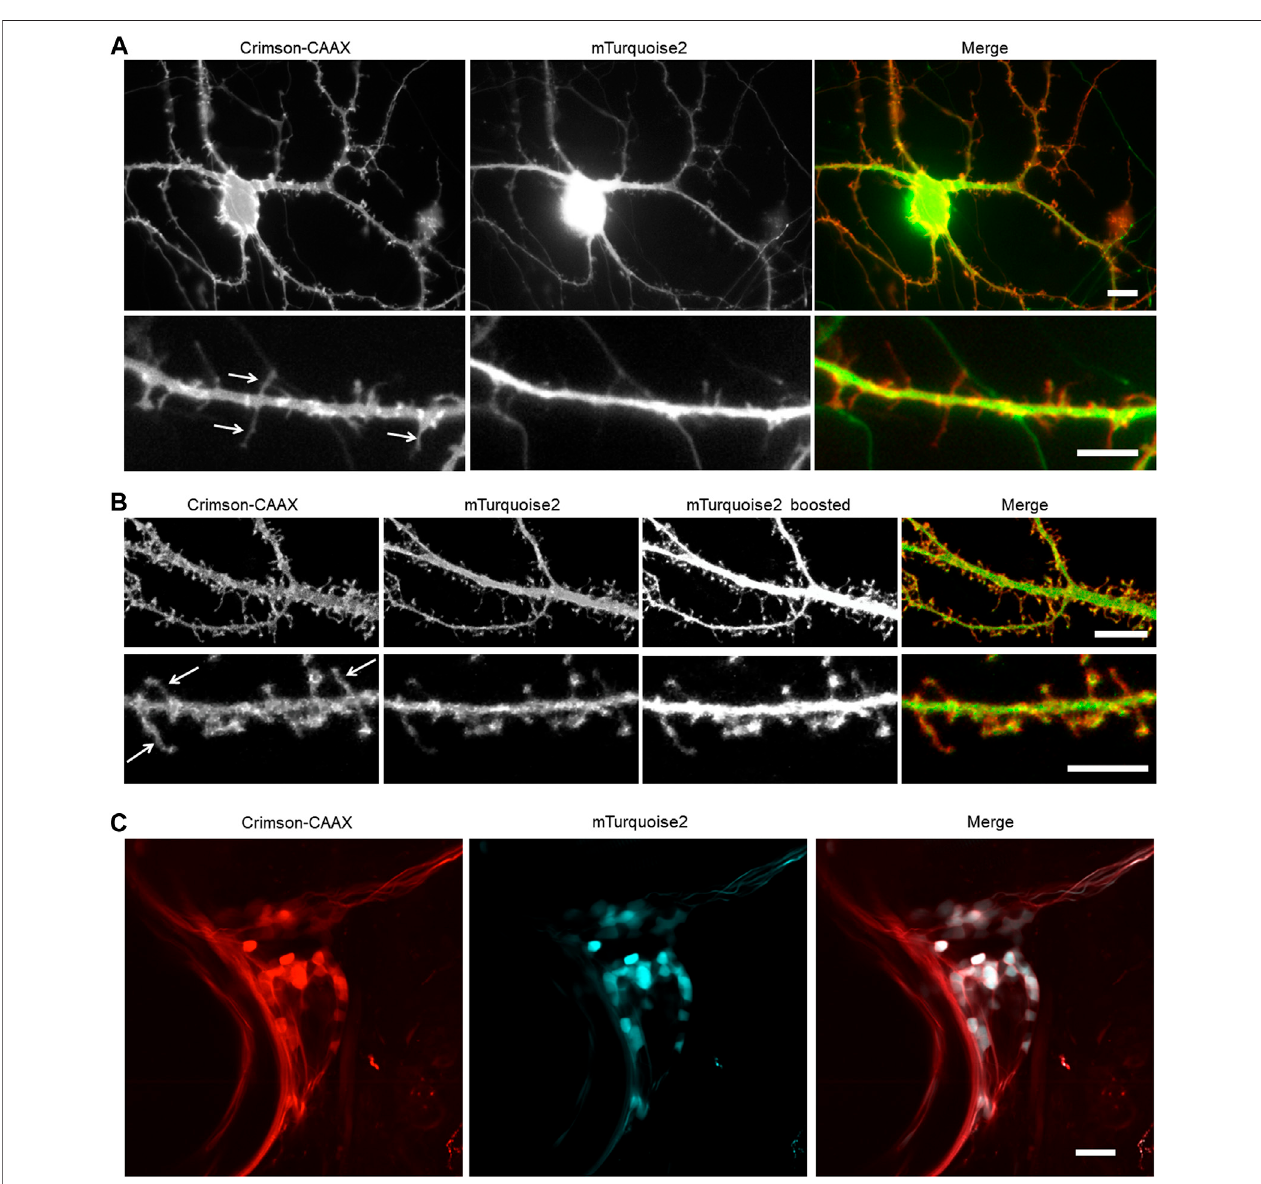
FIGURE 5 | Membrane-bound Crimson improves the detection of small processes. (A,B) Visualization of cultured rat hippocampal neurons with an epi fl uorescent microscope (A) and a confocal microscope (B) . Neurons were co-transfected with cytosolic mTurquoise2 and Crimson-CAAX at 9 DIV and imaged at 14 DIV. Lower panels show dendrites from the same culture at higher magni fi cation. Arrows indicate thin spines and fi lopodia visible with Crimson-CAAX but not with cytosolic mTurquoise2. Scale bars = 10 µm (upper panels) and 5 µm (lower panels). (C) Visualization of zebra fi sh trigeminal ganglion by two-photon microscopy in vivo . Zebra fi sh was injected with DNA at one-cell stage and imaged at 7-day post-fertilization. Scale bar = 20 µm.